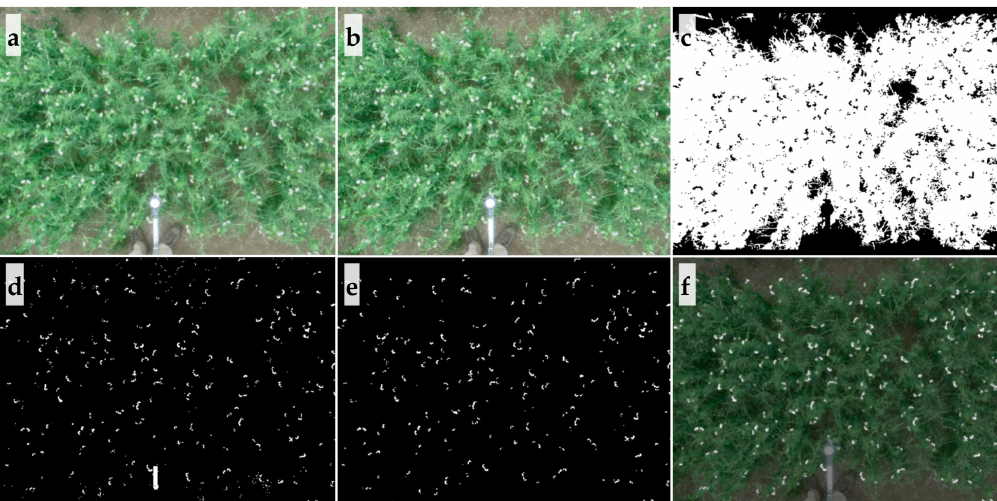
Figure 2. Procedure of image processing for pea. ( a ) Raw image; ( b ) radiometrically corrected image; ( c ) mask image for canopy; ( d ) mask for potential flowers with noises; ( e ) mask for potential flowers with noises removed; ( f ) overlapping of original image and noise-free flower